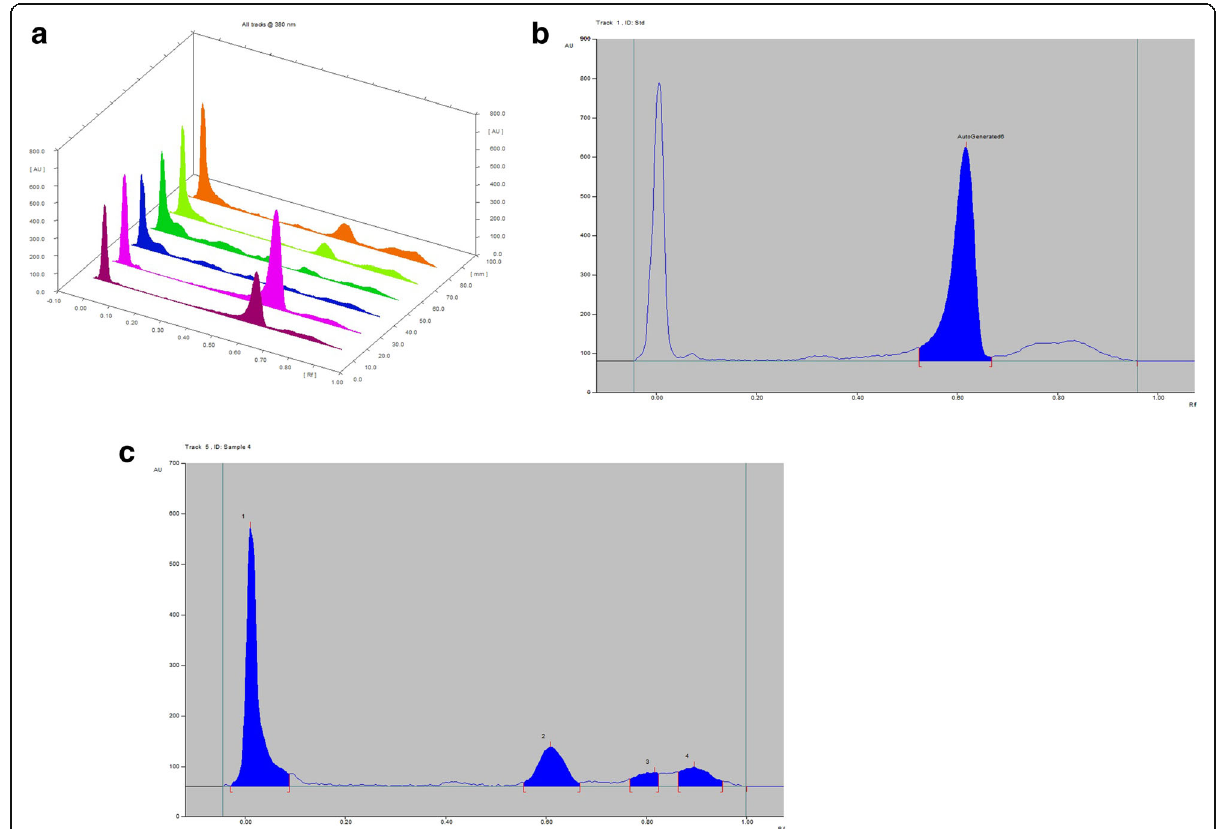
Fig. 6 HPTLC chromatogram of leaf extract with quercetin ( a ) 3D display of leaf extract with quercetin chromatogram, ( b ) HPTLC densitogram and chromatogram of standard quercetin and ( c ) leaf extract at 380 nm